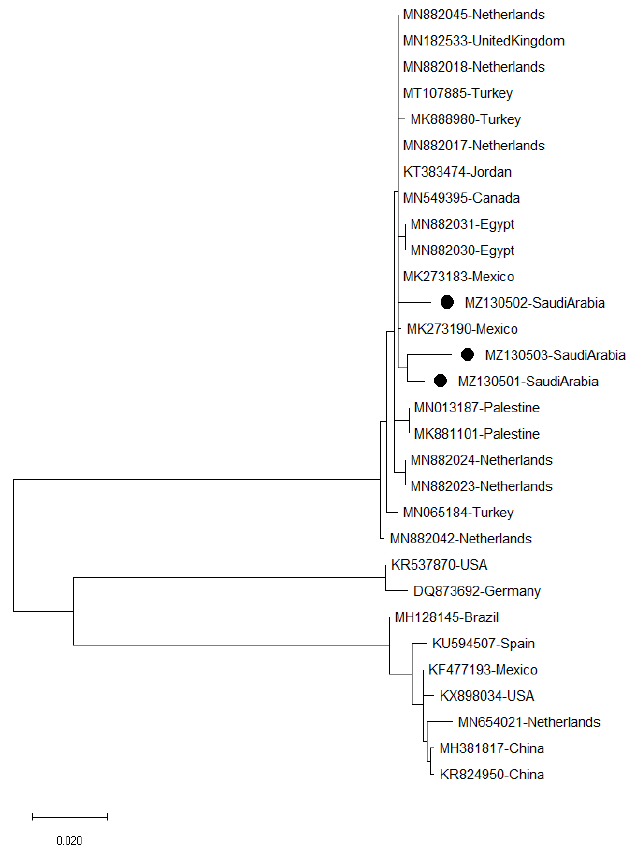
Figure 4. Phylogenetic tree based on multiple sequence alignment between three isolates of ToBRFV from Saudi Arabia and twenty-seven isolates documented in GenBank. Table 3. Similarity percentages of partial sequences of the RdRP gene of three Saudi isolates of ToBRFV with that of twenty-seven isolates of ToBRFV, ToMMV, and ToMV documented in